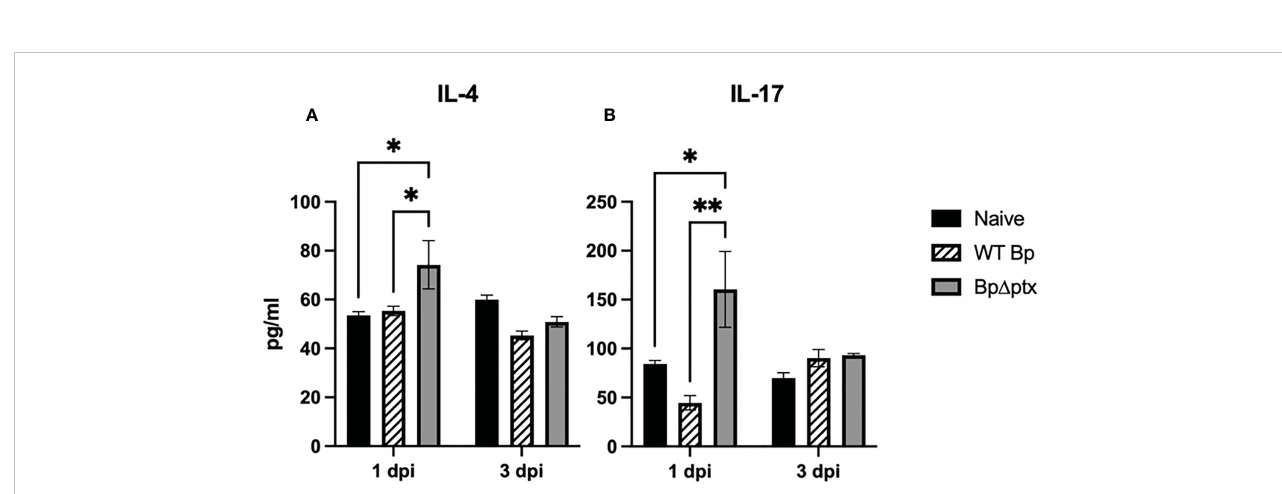
FIGURE 6 Pertussis toxin disrupts IL-4 and IL-17 production. Lung supernatant of C57BL/6J pups inoculated with WT Bp , Bp D ptx , or uninfected and assessed at 1 dpi and 3 dpi. IL-4 pg/ml (A) and IL-17 pg/ml (B) . Statistical signi fi cance was calculated via Two-way ANOVA, n=5. Error bars represent standard error of the mean. *p<0.0332, **p<0.0021.